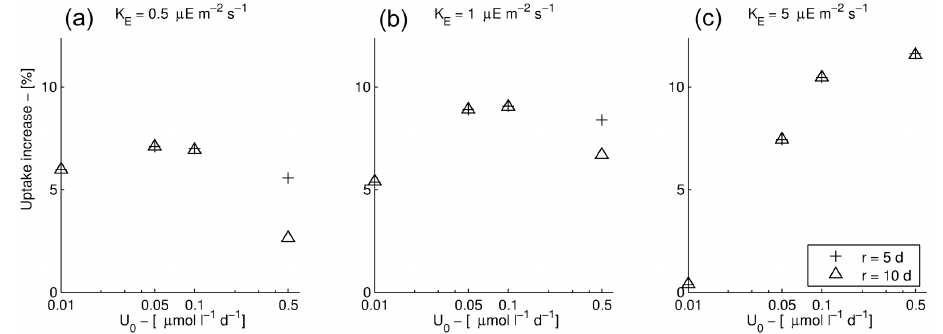
Figure 7. Average increase of nitrate uptake rates in the region of high mesoscale eddy activity (ca. 120–140 ◦ W and 22–26 ◦ S) for different values of the uptake coefficient U 0 and relaxation timescale r